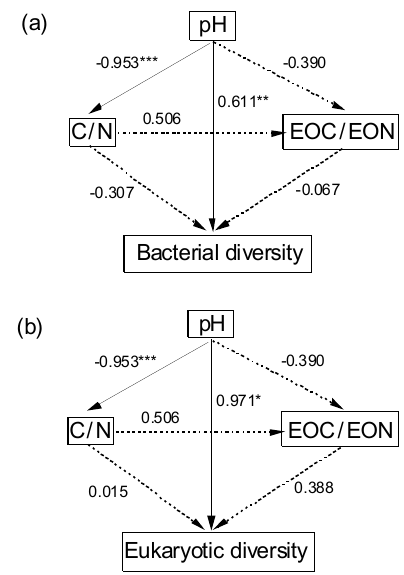
Figure 5. Path diagrams representing the final model showing the contributions of soil pH and nutrient quality to soil bacterial diver- sity (a) and eukaryotic diversity (b) under different tree species. Numbers associated with single-headed arrows are partial regres- sion coefficients of multiple regressions. C:N, ratio of soil total C to total N contents; EOC:EON, ratio of soil extractable organic C to extractable organic N contents. Solid arrows denote the direc- tions and effects that were significant ( P < 0 . 05); the numbers on these pathways are the coefficients. Dashed arrows represent the directions and effects that were not significant ( P > 0 . 05). ∗ , ∗∗ and ∗∗∗ indicate significant differences at P < 0 . 05, P < 0 . 01 and P < 0 . 001,